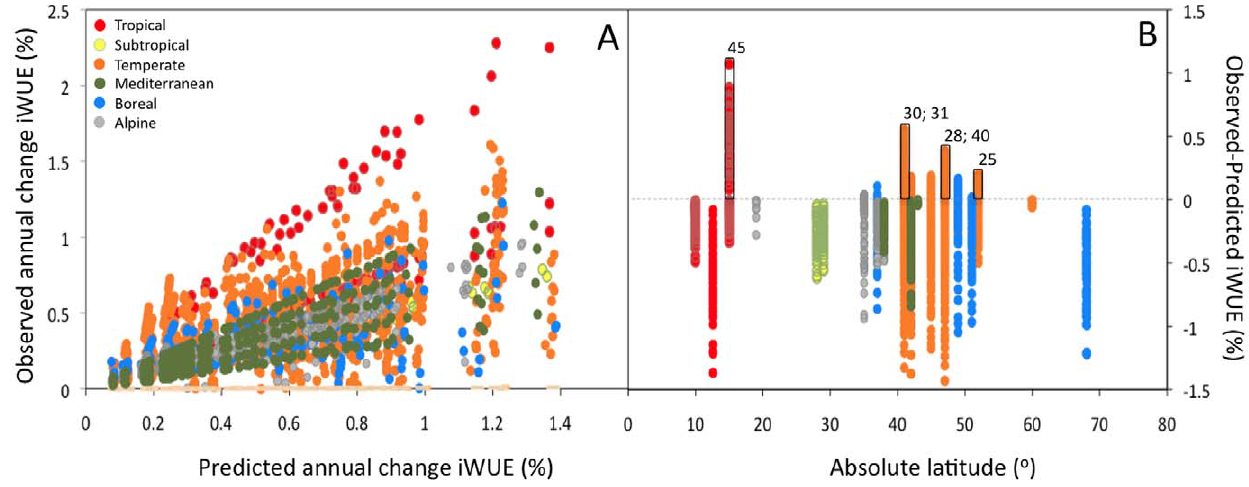
Figure 3. Relationships between iWUE predicted based on simulated d 13 C values (Fig. 1), corrected for changes with calendar year and altitude (Fig. 2), and iWUE observed from in 49 case studies. (A). Difference between observed and predicted change in iWUE (B). Note that only six case studies, namely 25, 28, 30, 31, 40 and 45 (Table S1) showed increases in iWUE significantly higher than predicted from simulated d 13 C data (upper 95% confidence interval across latitudes in panel B=0.3%).